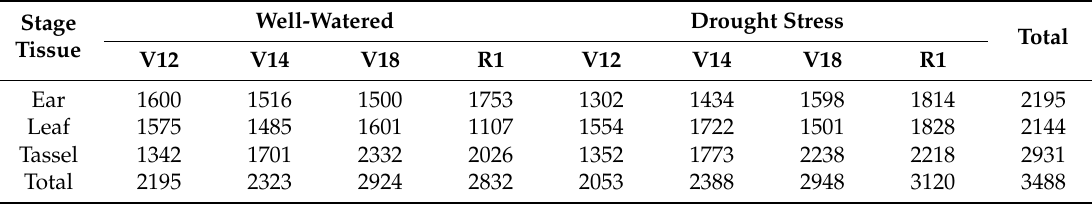
Table 1. Number of lncRNAs found in different tissues at different stages and